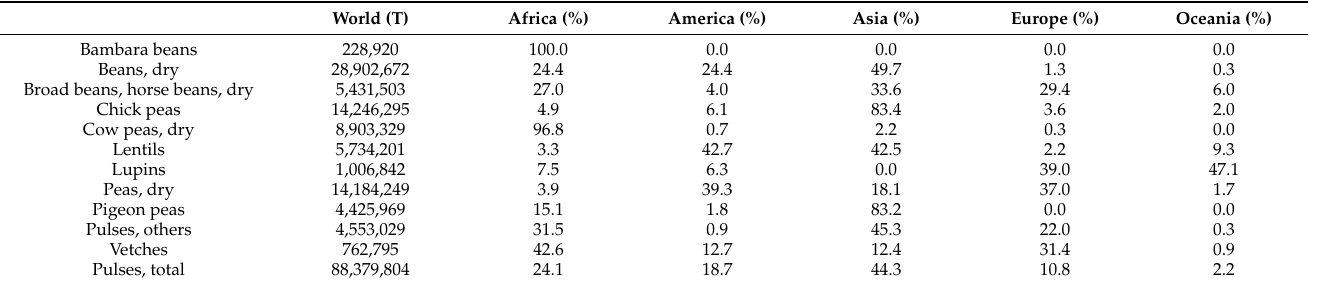
Table 1. World production of pulses in tons (T) and contribution percentage (%) of each continent (Faostat 2019). World (T) Africa (%) America